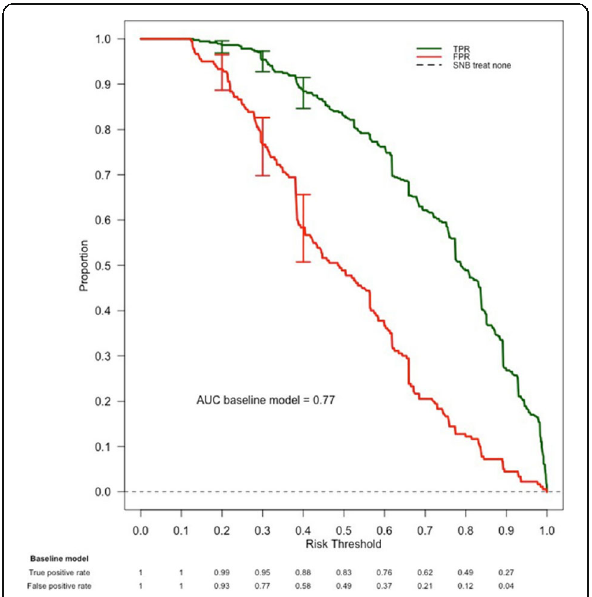
Fig. 1 (abstract O35). Classification plots showing sensitivity (true positive rate, TPR) and false positive rate (FPR) by threshold for the baseline model only (with 95% pointwise confidence intervals of TPR and FPR for risk thresholds of 20%, 30%, 40% for risk of metastatic